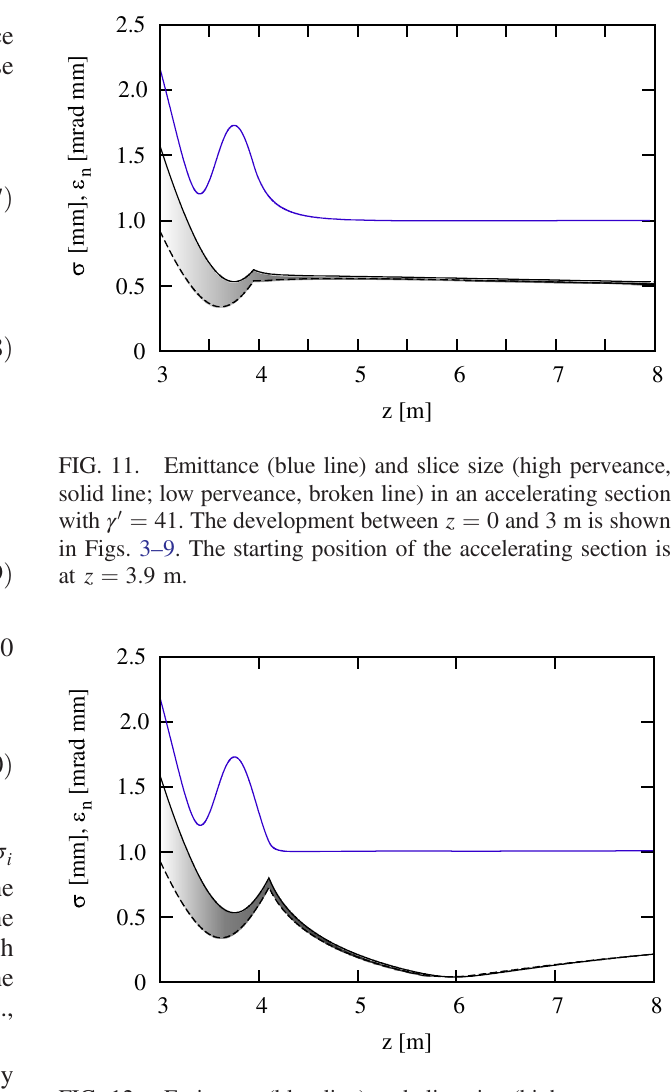
FIG. 12. Emittance (blue line) and slice size (high perveance, solid line; low perveance, broken line) in an accelerating section with γ 0 ¼ 82 . The development between z ¼ 0 and 3 m is shown in Figs. 3 – 9. The starting position of the accelerating section is at z ¼ 4 . 1